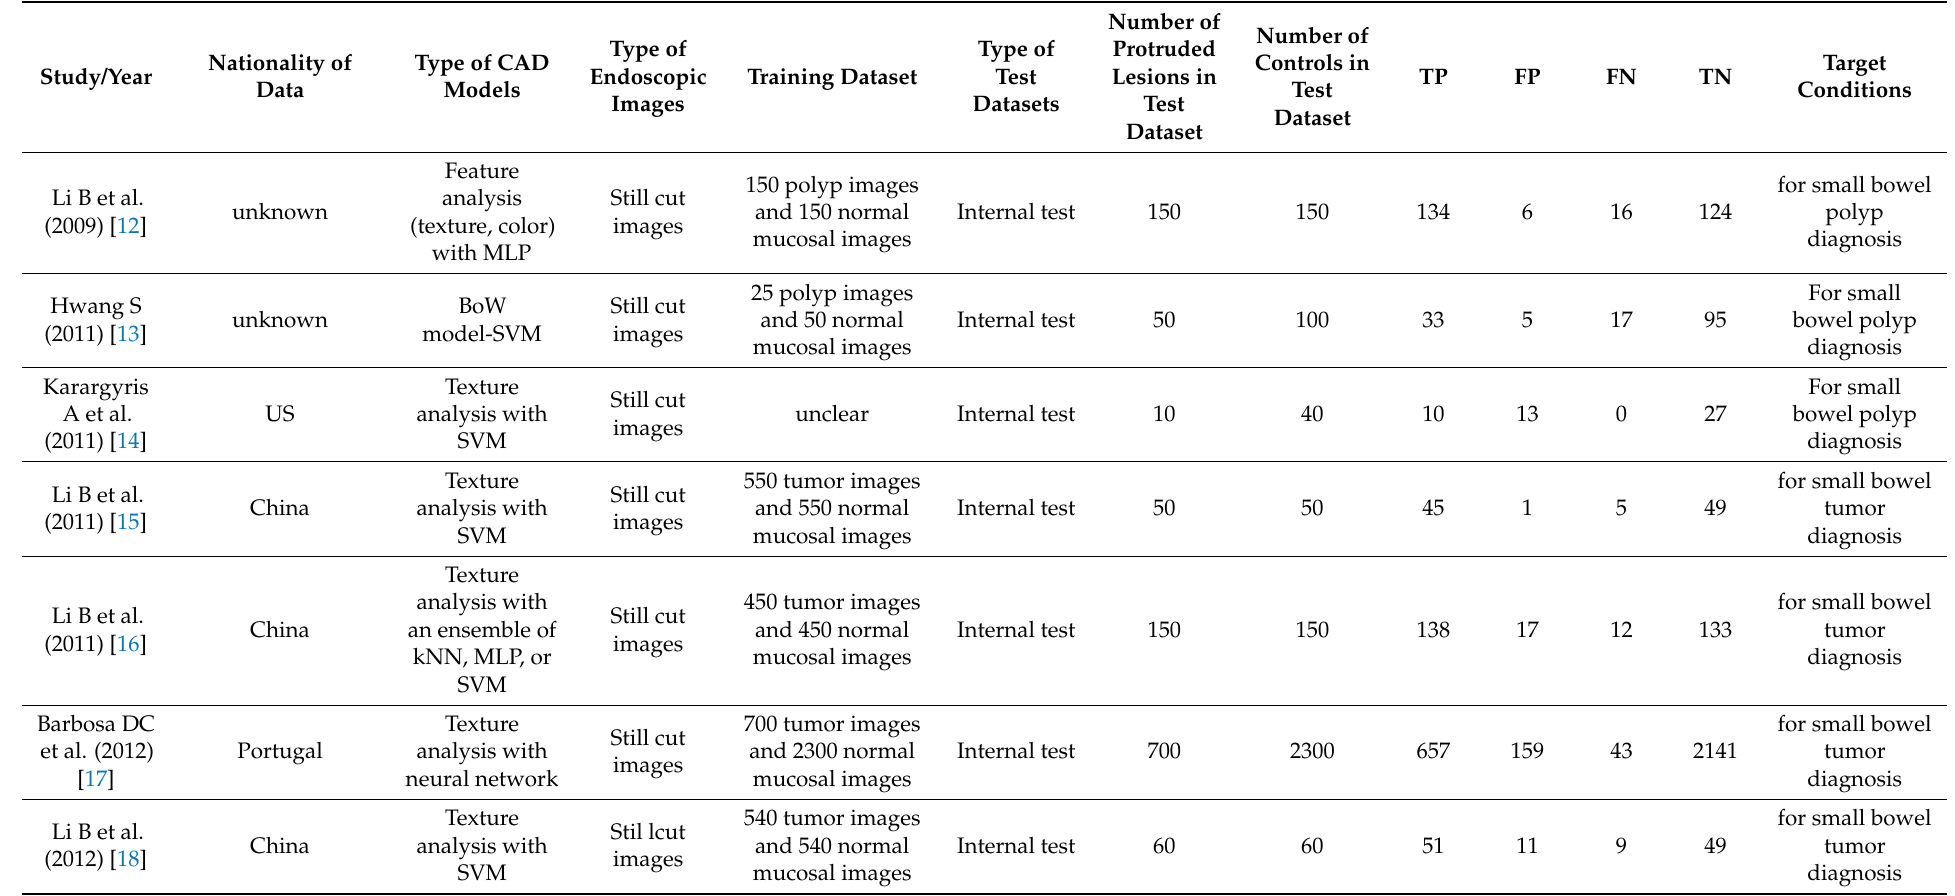
Table 2. Clinical characteristics of the included studies for the diagnosis of gastrointestinal protruded lesions in wireless capsule endoscopy images using computer-aided